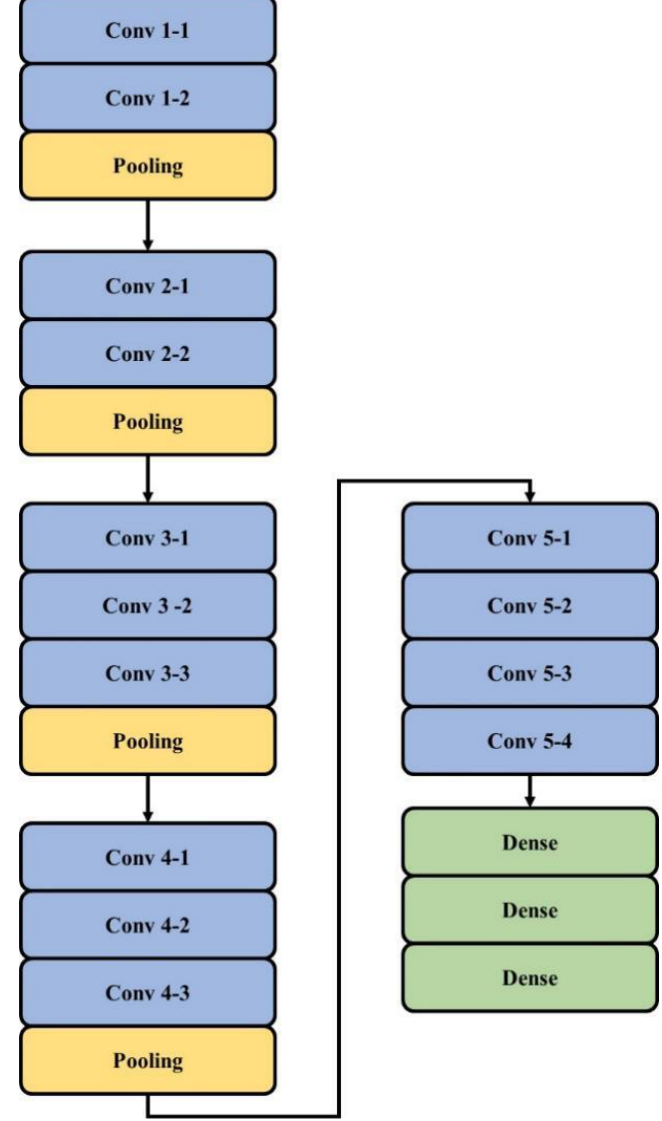
Figure 4. VGG16 architecture in feature extraction.